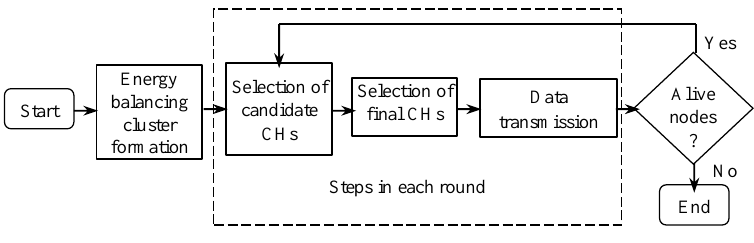
Figure 3. Stages of the proposed approach. After the cluster formation, BS enforces the operation of the network into